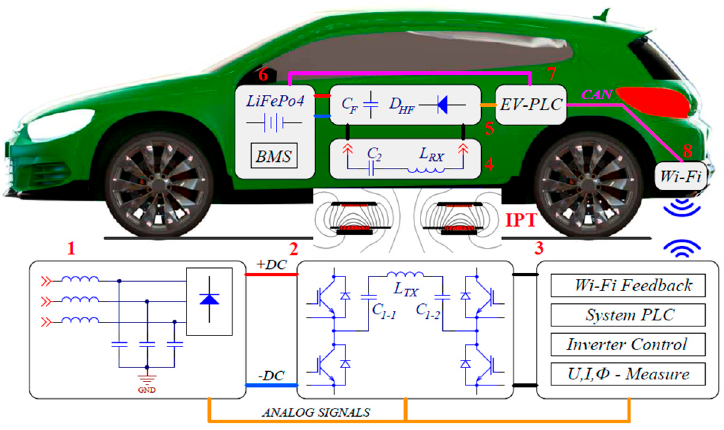
Figure 1. A schematic overview of inductive power transfer (IPT) charging station architecture.